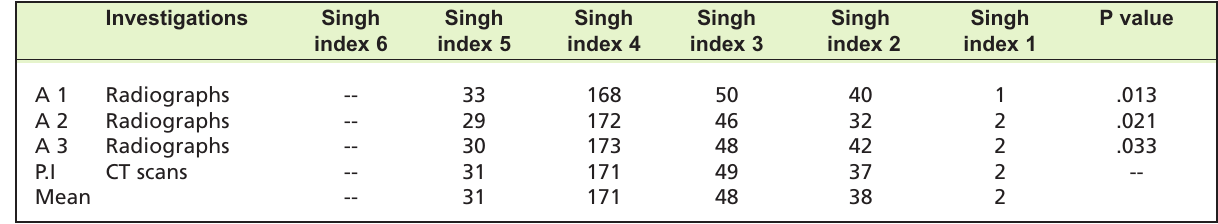
Inter-observer reliability of the analysers Table VI: